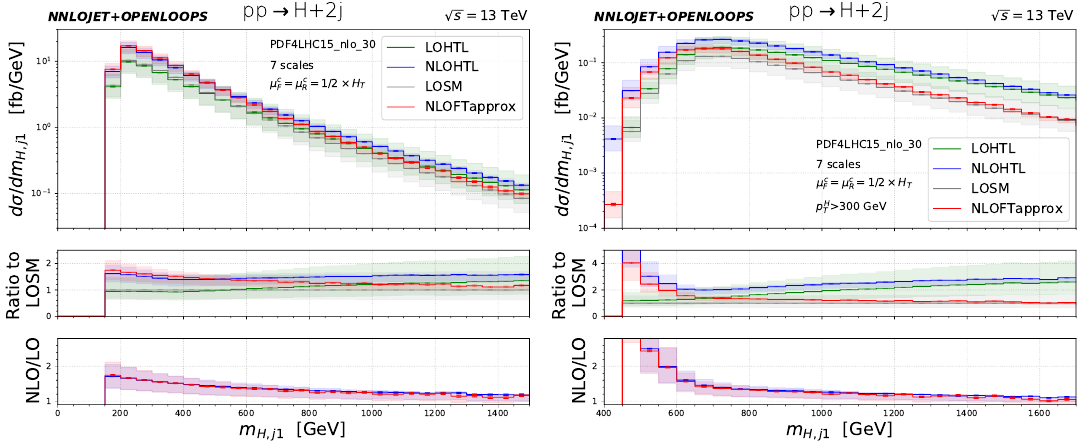
Figure 5 . Invariant mass distribution of the Higgs and the hardest jet system in H+2 jets production. Colour coding and labelling as in figure 2.